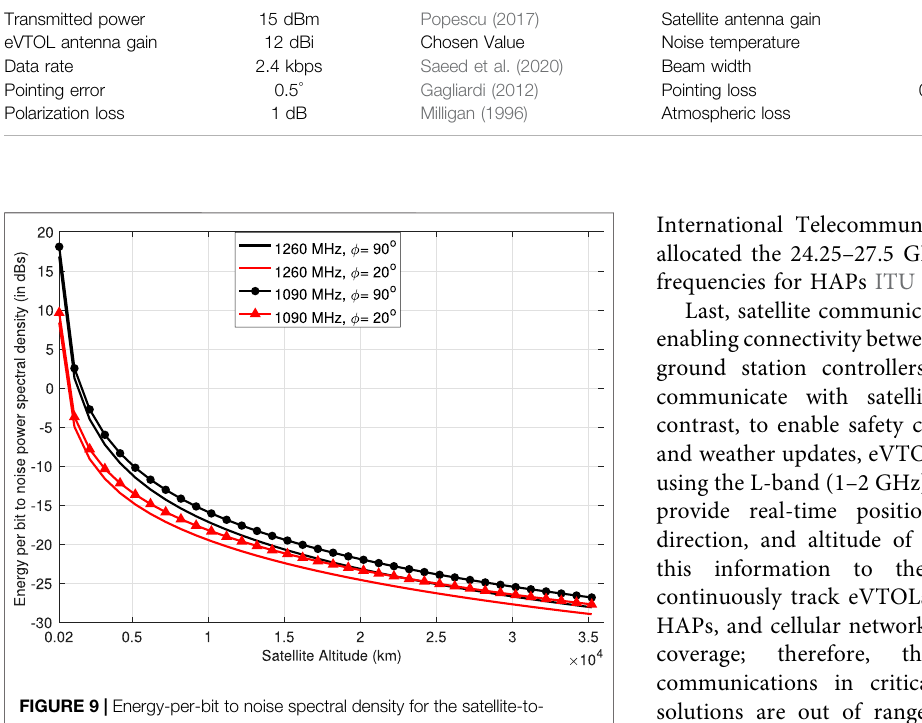
TABLE 2 | Parameters of calculating the energy-per-bit to noise spectral density for the satellite-to-eVTOL link. Parameter Values Ref. Ref.